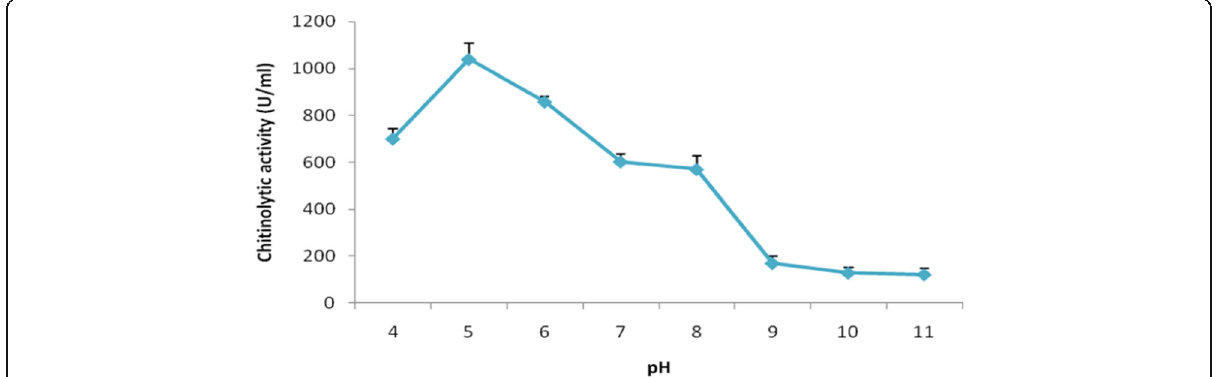
Fig. 5 Effect of different buffer pH on chitinase activity of S . maltophilia JF66, grown at optimized